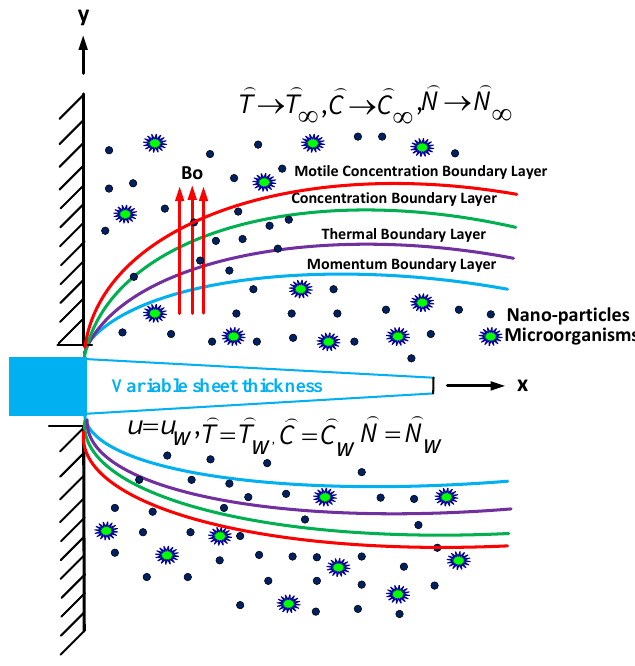
Figure 1. Flow diagram with variable thickness